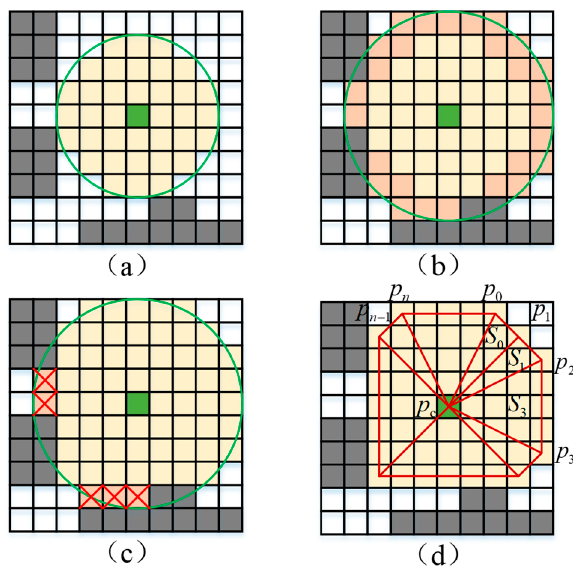
Figure 2. Main steps of the regional dynamic growth algorithm. ( a ) Growth state at a certain moment. ( b ) The next moment is grown in a circular expansion manner to obtain adjacent candidate points. ( c ) Remove the unqualified points in the adjacent candidate points. ( d ) Add qualified candidate points to the topological region.